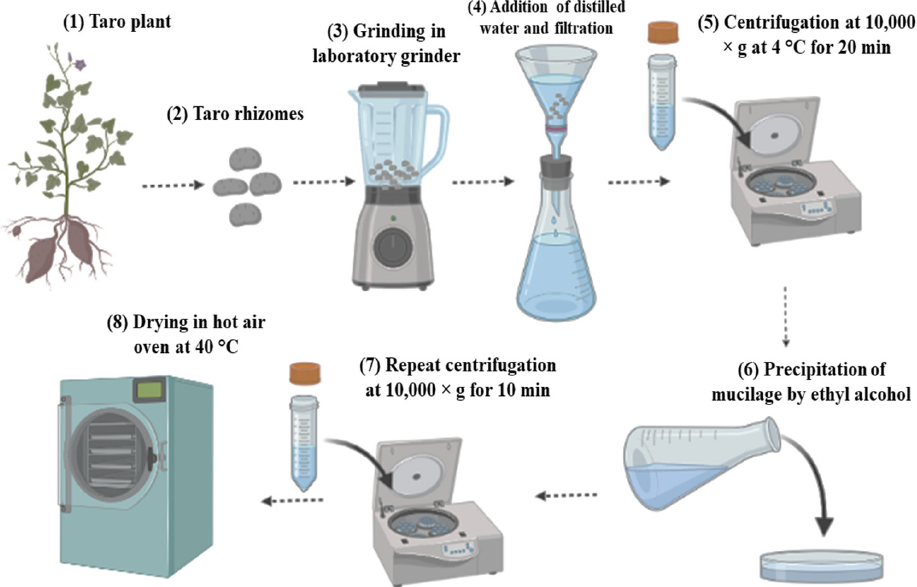
Figure 1. Schematic representation diagram of the extraction of taro mucilage at low temperature with ethanol precipitation.